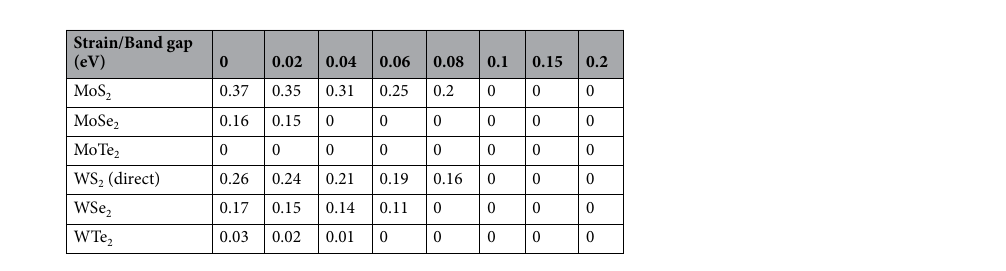
Table 3. Band gap variation of Y-arc